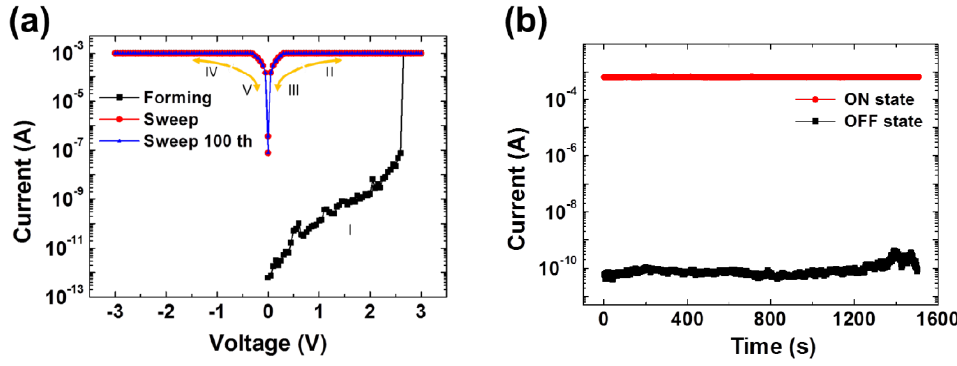
Figure 6. ( a ) I-V characteristic of the ITO/PI-GO/Al device under ambient air conditions at room temperature; ( b ) Retention performance of the ITO/PI-GO/Al device at room temperature (Read at 0.2 V).